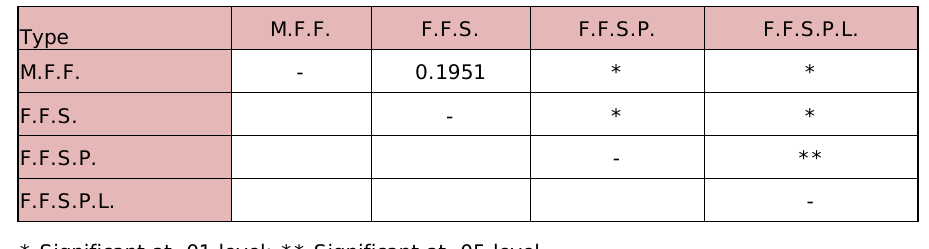
Table 5. “Fisher’s LSD on Number of Fixation Groups”. Source: Own contribution.